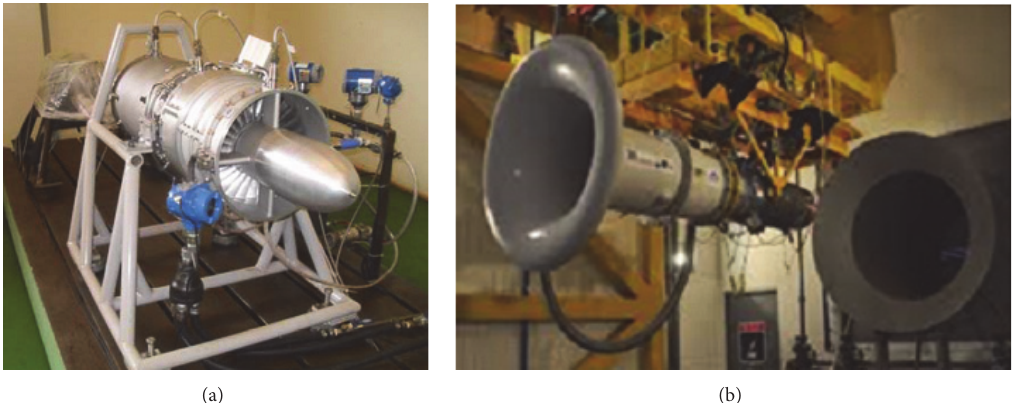
Figure 1: Manufactured single spool gas turbine developed in this study: (a) apparatus for demonstrative purposes and preliminary tests and (b) test rig for full test protocol.